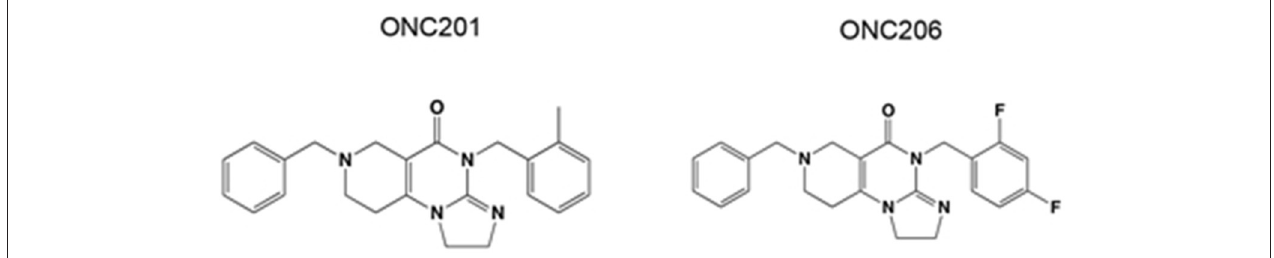
FIGURE 1 | Chemical structure of ONC201 and